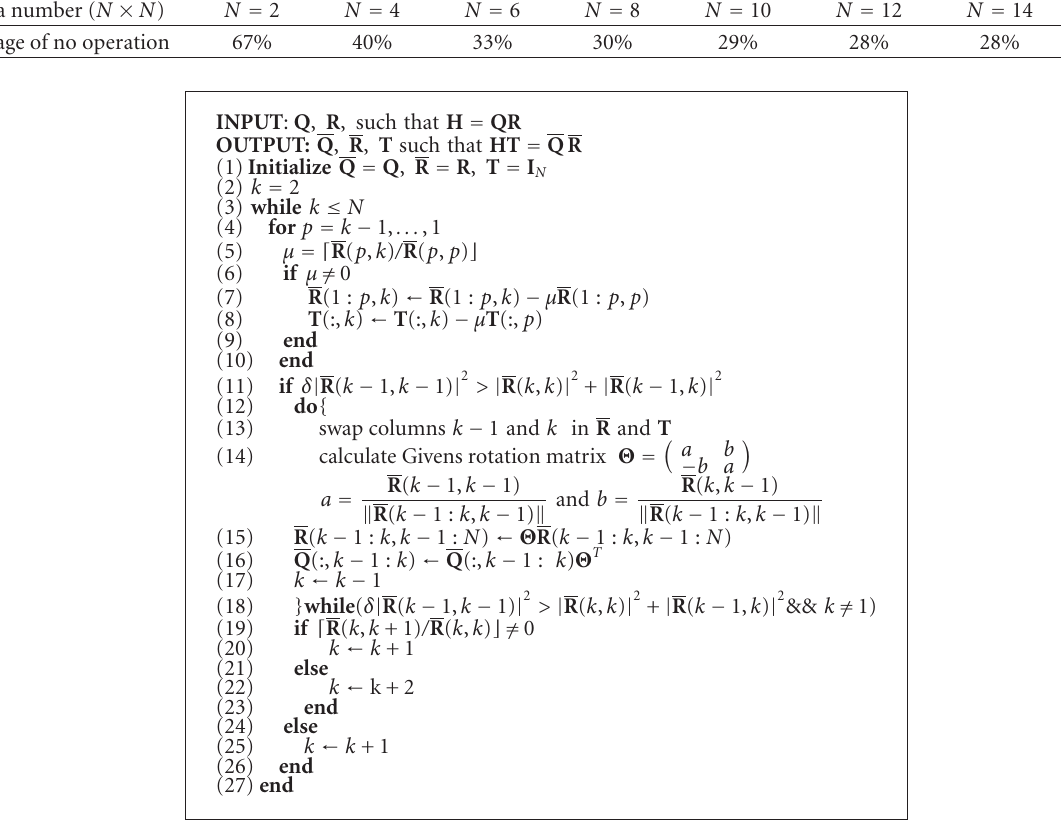
Algorithm 2: The proposed loop reduction LLL algorithm using look-ahead check